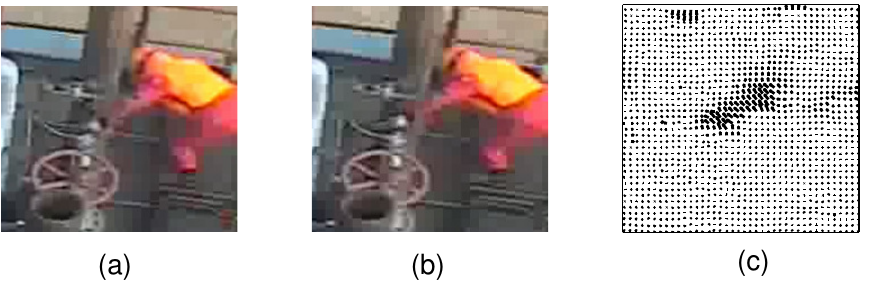
Figure 9. Illustration of the Optical Flow Descriptor. ( a , b ) Reference images at time t and t + 1; ( c ) Computed optical